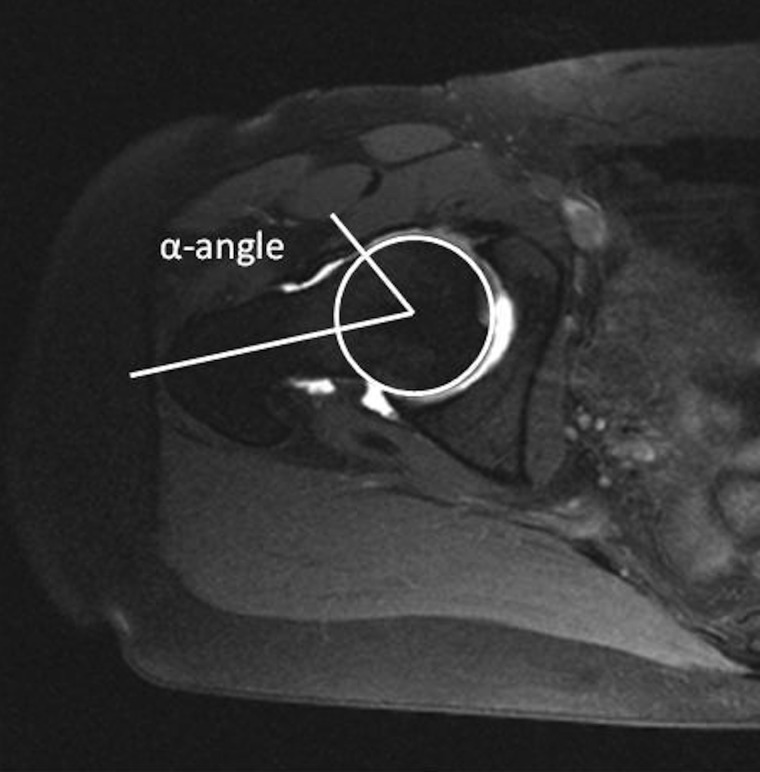
MRA measurement of the α-angle of Notzli on the oblique plane. After identification of the center of the femoral head, a line along the middle of the femoral neck and a line from the center to the point where the femoral head-neck junction ‘left’ the best fitted circle of the femoral head make up the α-angle.